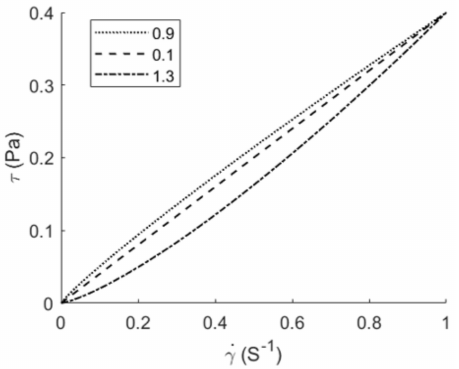
Figure 2. Stress changes versus shear rates in power-law fluids for different n ( λ =